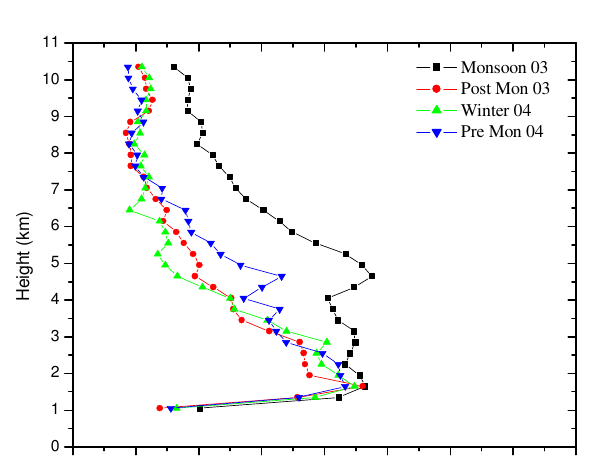
Fig. 6. Height profile of mean Log C 2 n for different seasons, year